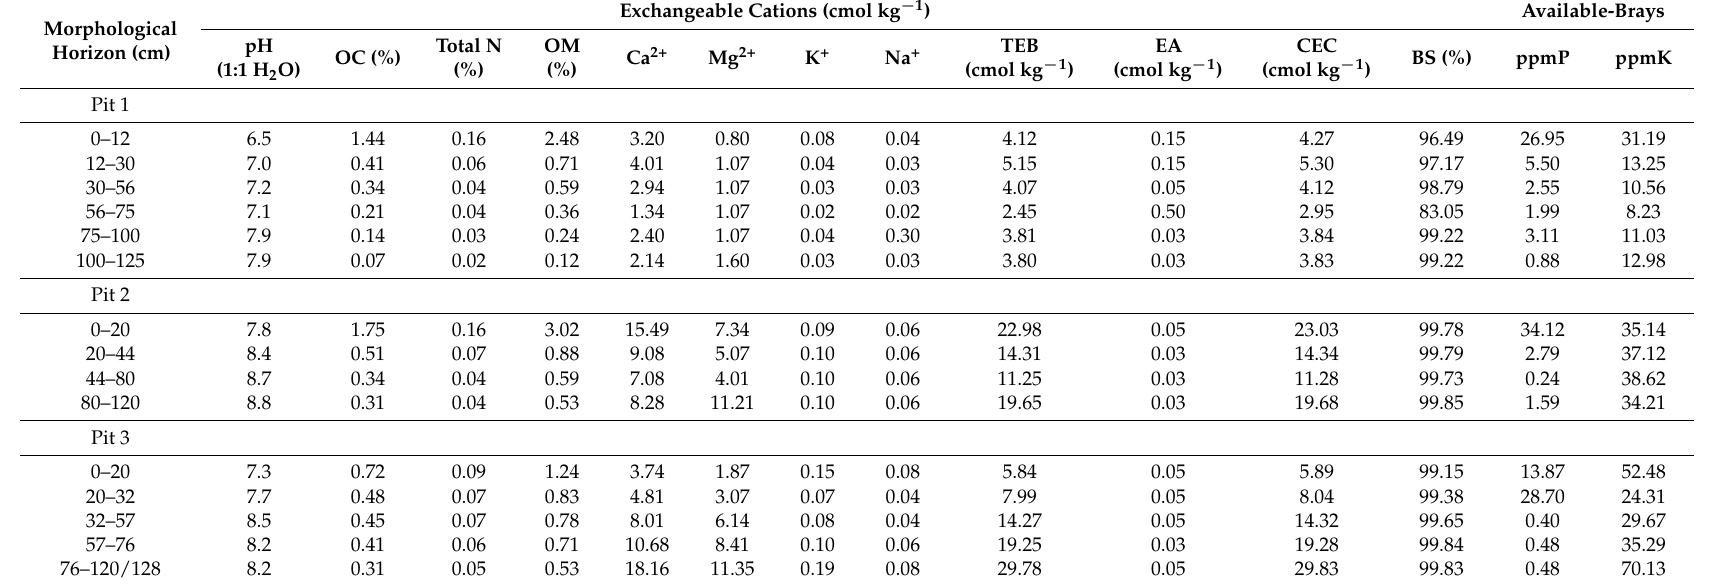
Table A1. Chemical properties of soils in the Bongo and Vea irrigation